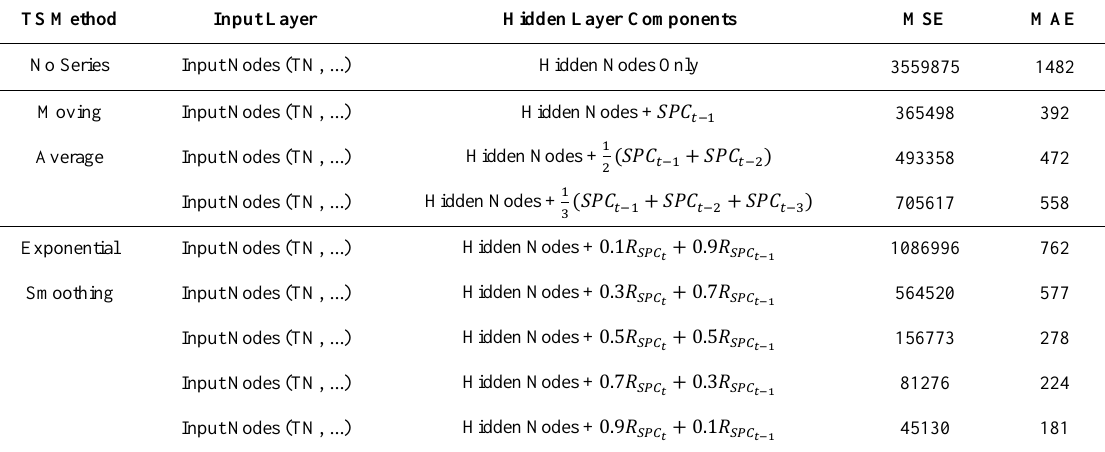
Table 6. Summary of different structures for neural network model and performance criteria